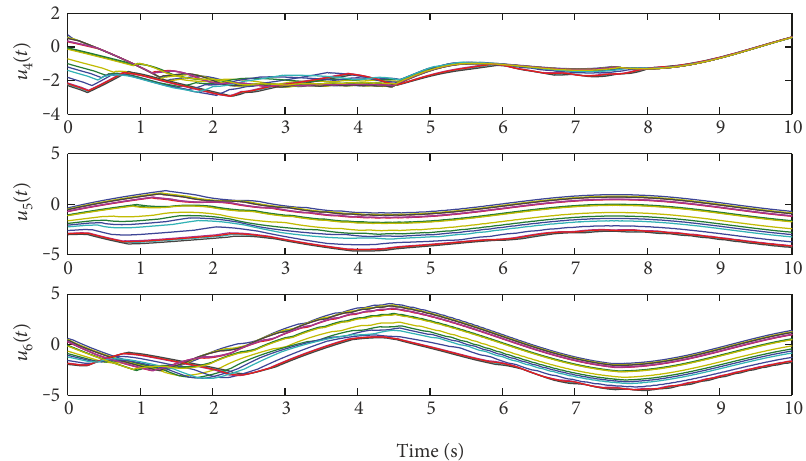
Figure 6: Virtual de fl ection angle control commands for the last three SJA arrays (i.e., u